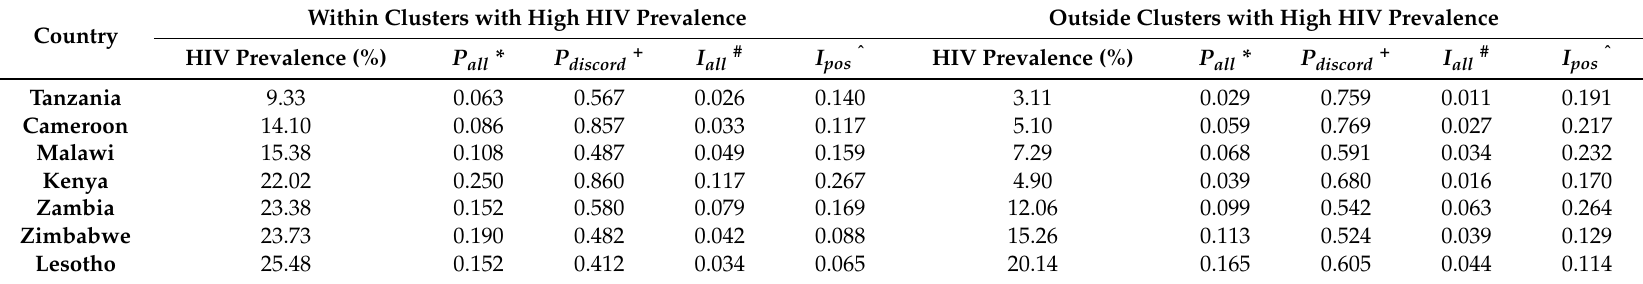
Table 2. Epidemiological measures of HIV sero-discordancy within and outside of clusters with high HIV prevalence in each of the countries included in the study. Within Clusters with High HIV Prevalence Outside Clusters with High HIV Prevalence Country HIV Prevalence (%) P all